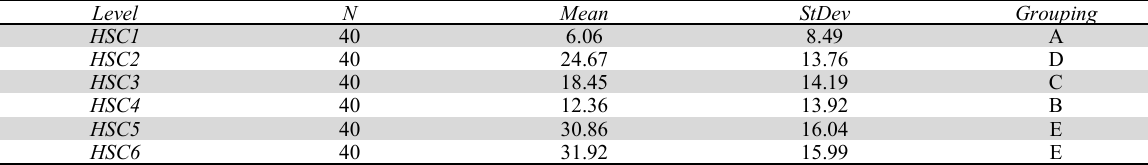
Individual 95% CIs For Mean Based on Pooled StDev and grouping Information